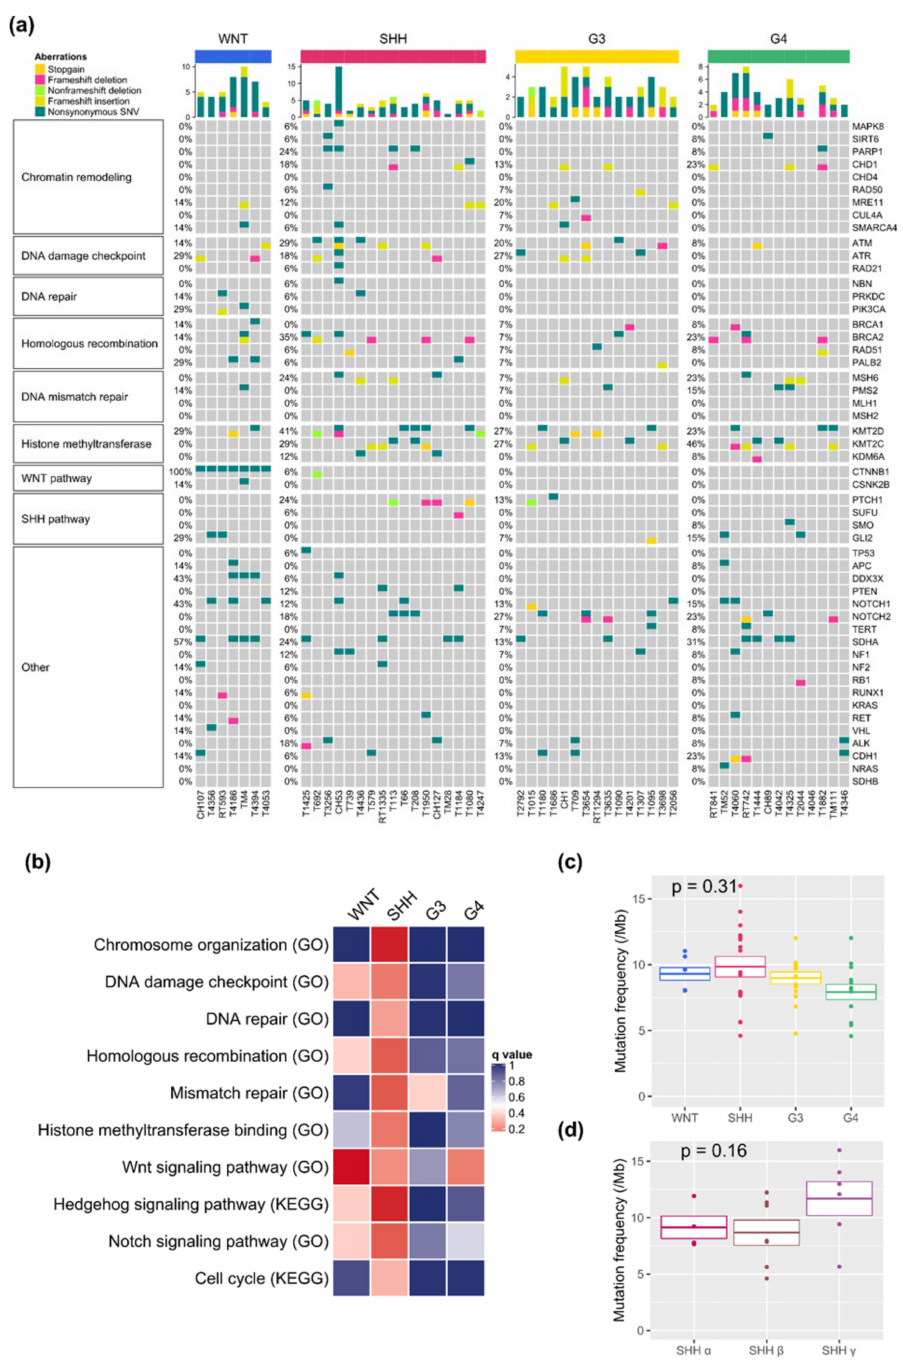
Figure 4. Calling of somatic mutations based on RNA-Seq in a selected list panel of 51 clinically relevant genes in the cohort series of 52 childhood MBs. ( a ) Prevalence and subgroup distributions of the somatic mutations. ( b ) Subgroup distribution of a ff ected signature pathways. Significant signature pathways were identified based on gene set enrichment analysis and annotation was identified based on Gene Ontology (GO) and the Kyoto Encyclopedia of Genes and Genomes (KEGG) pathway database. Mutation frequency in the four core molecular subgroups ( c ) and SHH subtypes ( d ). SHH tumors carried the highest mutation frequency (9.8 / Mb) ( p = 0.31, Kruskal-Wallis test). Among SHH subtypes, SHH γ carry the highest mutation frequency (11.7 / Mb) ( p = 0.16, Kruskal-Wallis